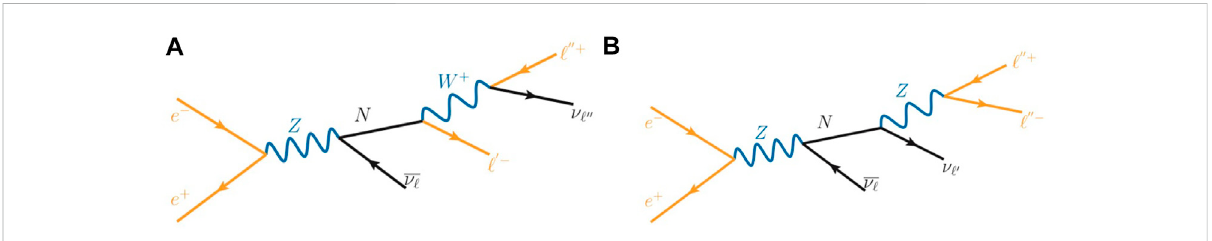
FIGURE 11 Representative diagrams depicting the e + e − → Z → N ] ℓ process at leading order, with N decaying via (A) charged current and (B) neutral current channels to the two-neutrino, two-charged lepton fi nal state.